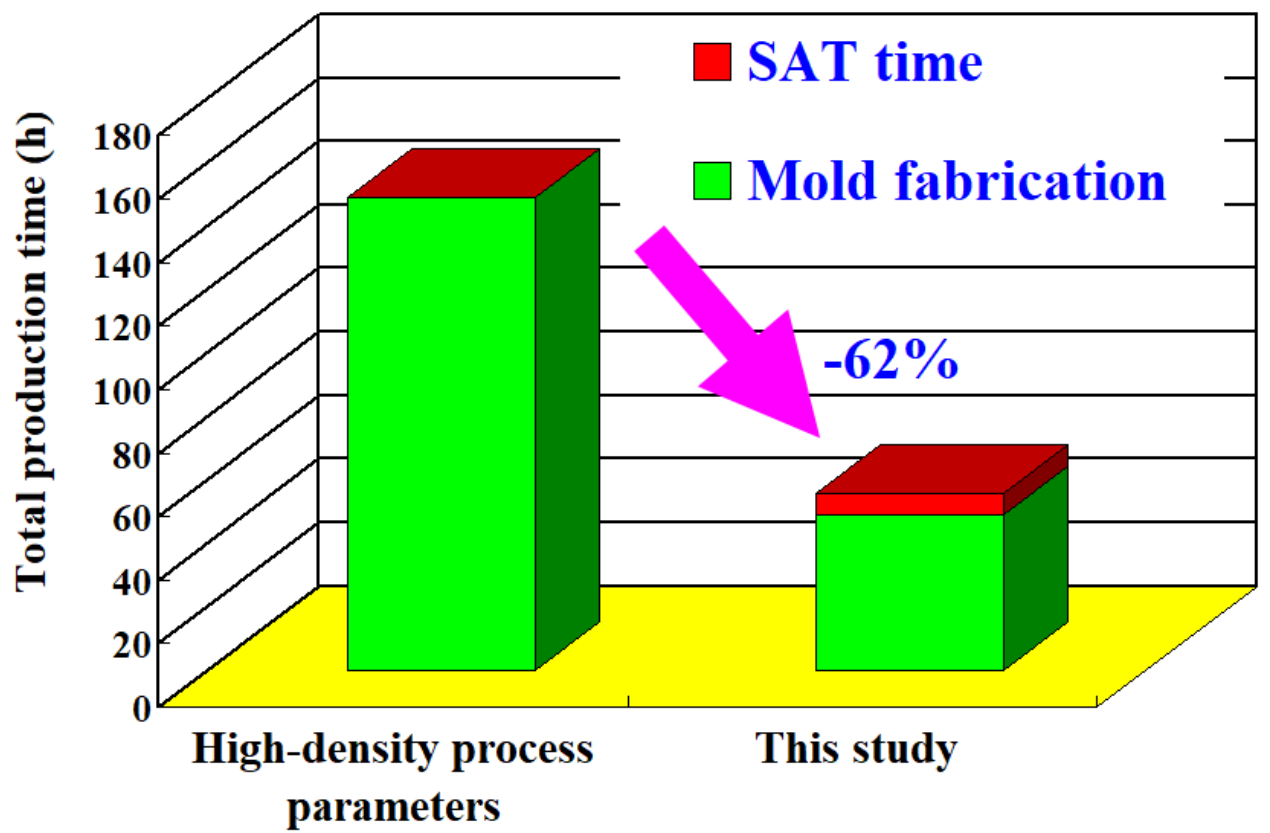
Figure 13. Total production time of an injection mold fabricated by high-density process parameters and the process parameters utilized in this study.